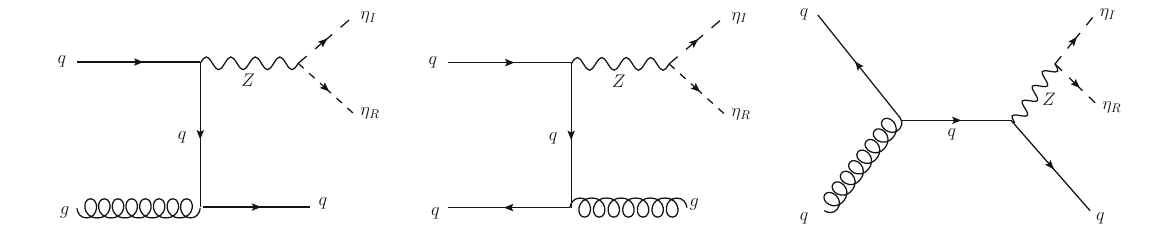
Fig. 8 Feynman diagrams illustrating Z -mediated production of η R η I + j at the LHC